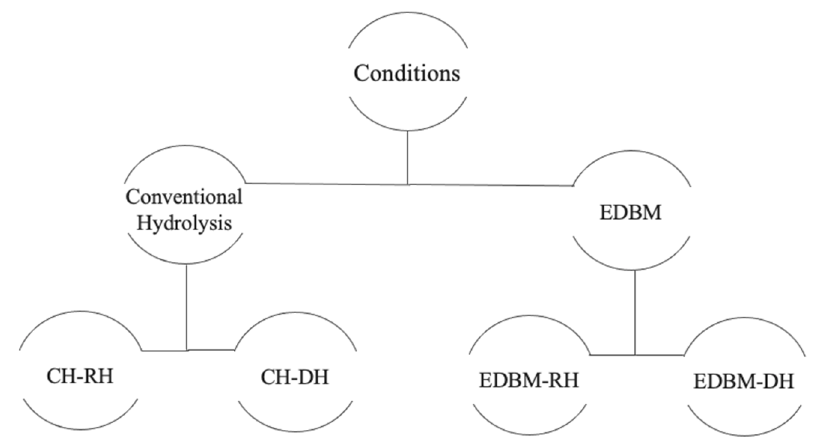
Figure 2. Diagram summarizing the hydrolysates recovered in each condition.